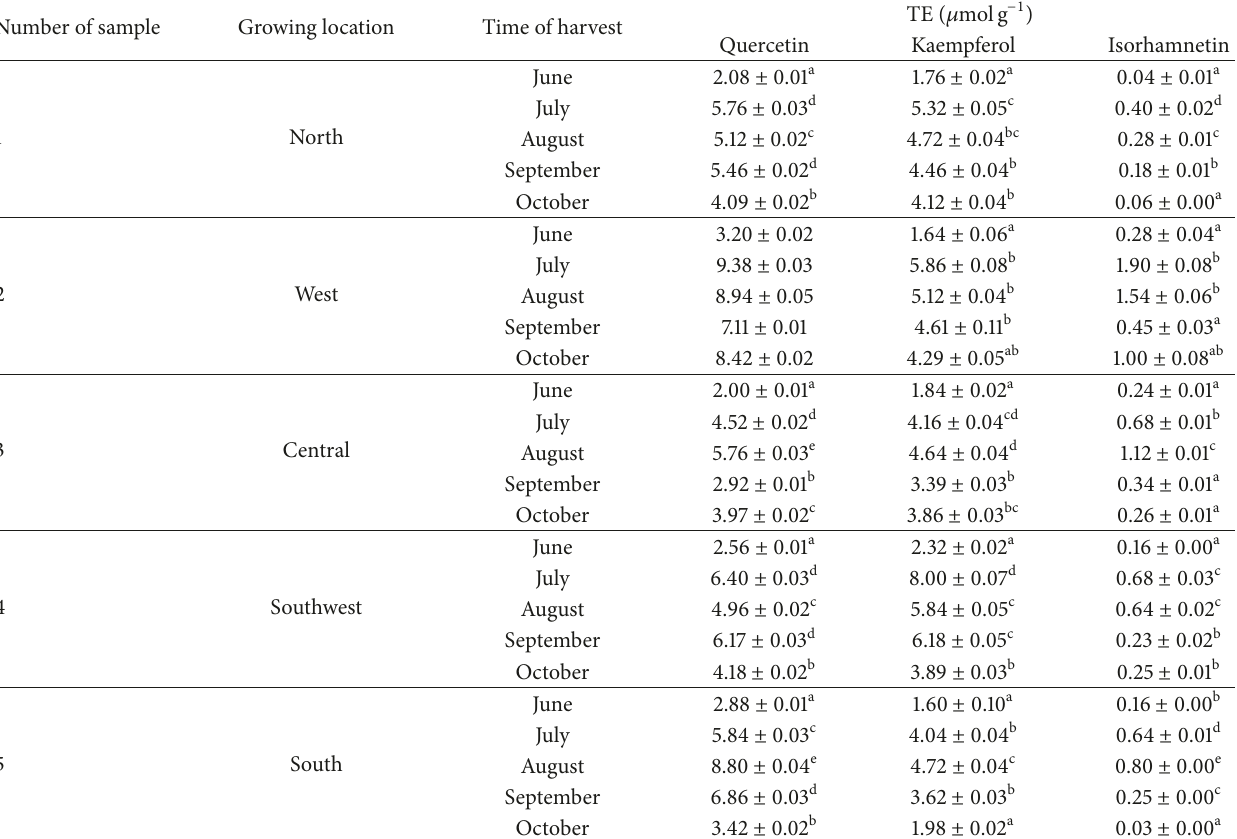
Table 6: TE values of G. biloba leaf in ABTS postcolumn